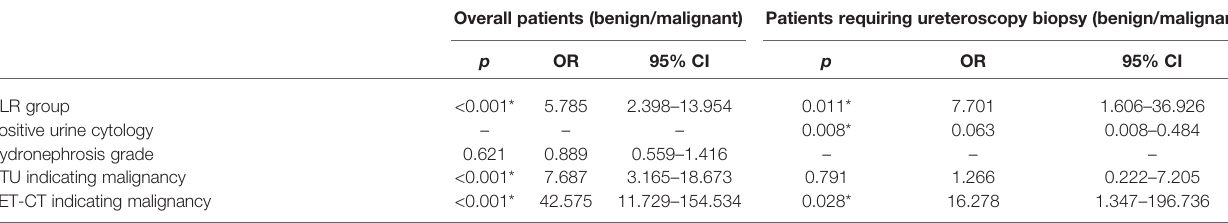
TABLE 3 | Multivariate logistic regression analysis exploring independent predictors of malignant UUT